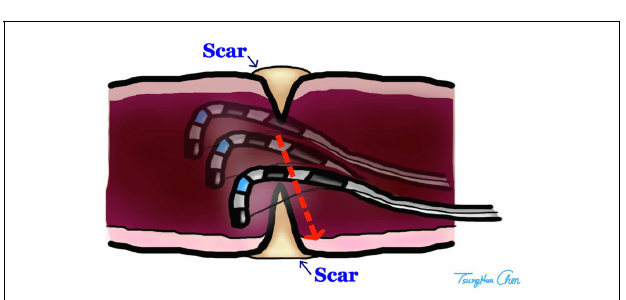
FIGURE 3 |The depth of incision was limited by the arms of